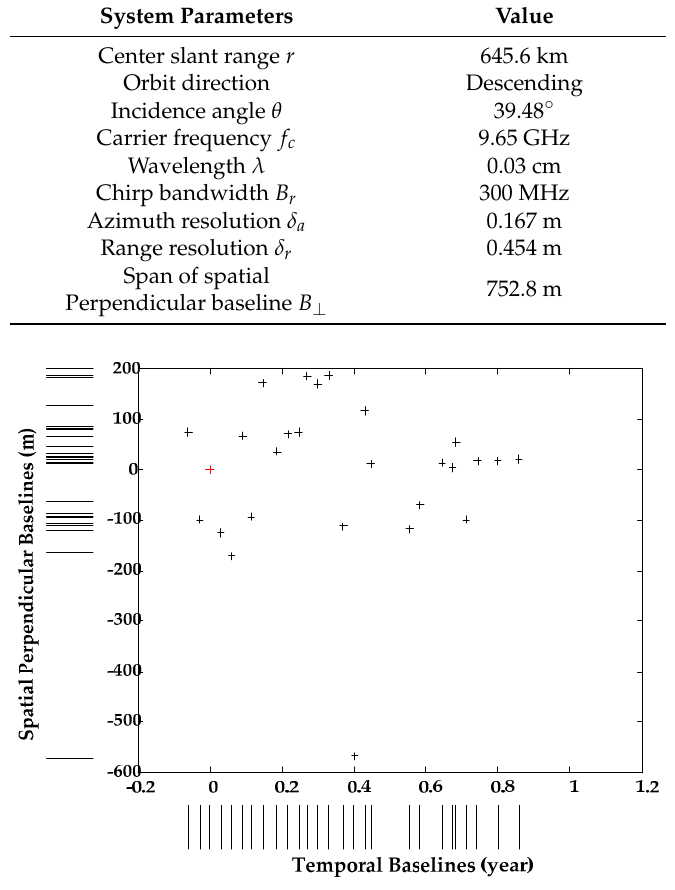
Figure 4. Distribution of the temporal baselines and spatial perpendicular baselines.